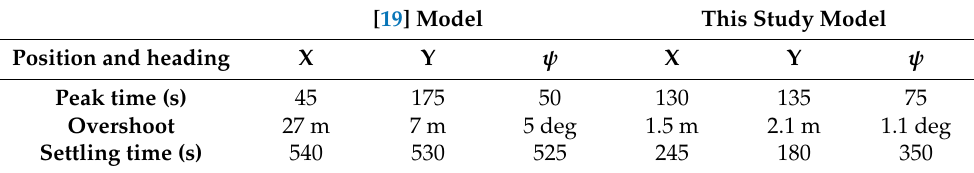
Table 4. Quantified position and heading control differences with Reference